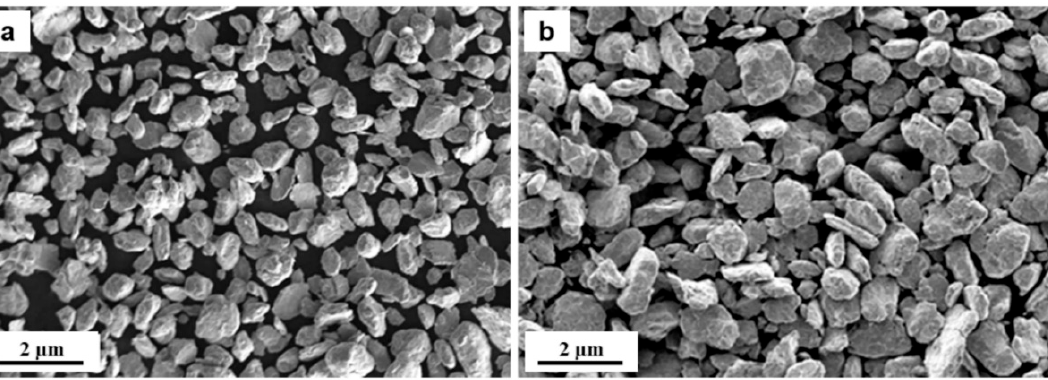
Figure 1. Powder morphology after 50 h of milling: ( a ) ODS-0.45Zr, ( b ) ODS-0.60Zr.